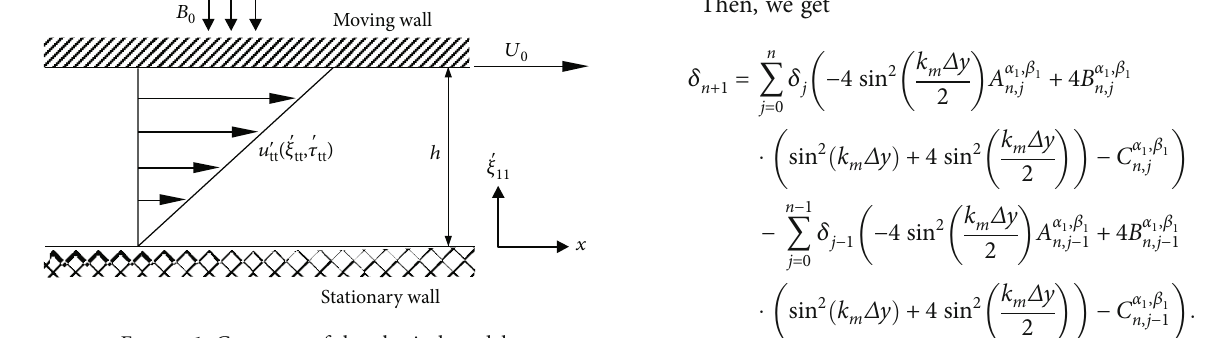
Figure 1: Geometry of the physical